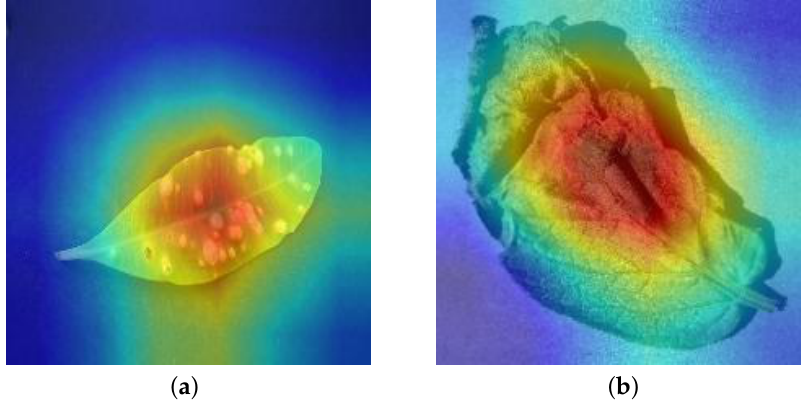
Figure 3. LFM-CNAPS classification basis is visualized by TAM. ( a ) the sample of diseased Alstonia Scholari; ( b ) the sample of potato with late